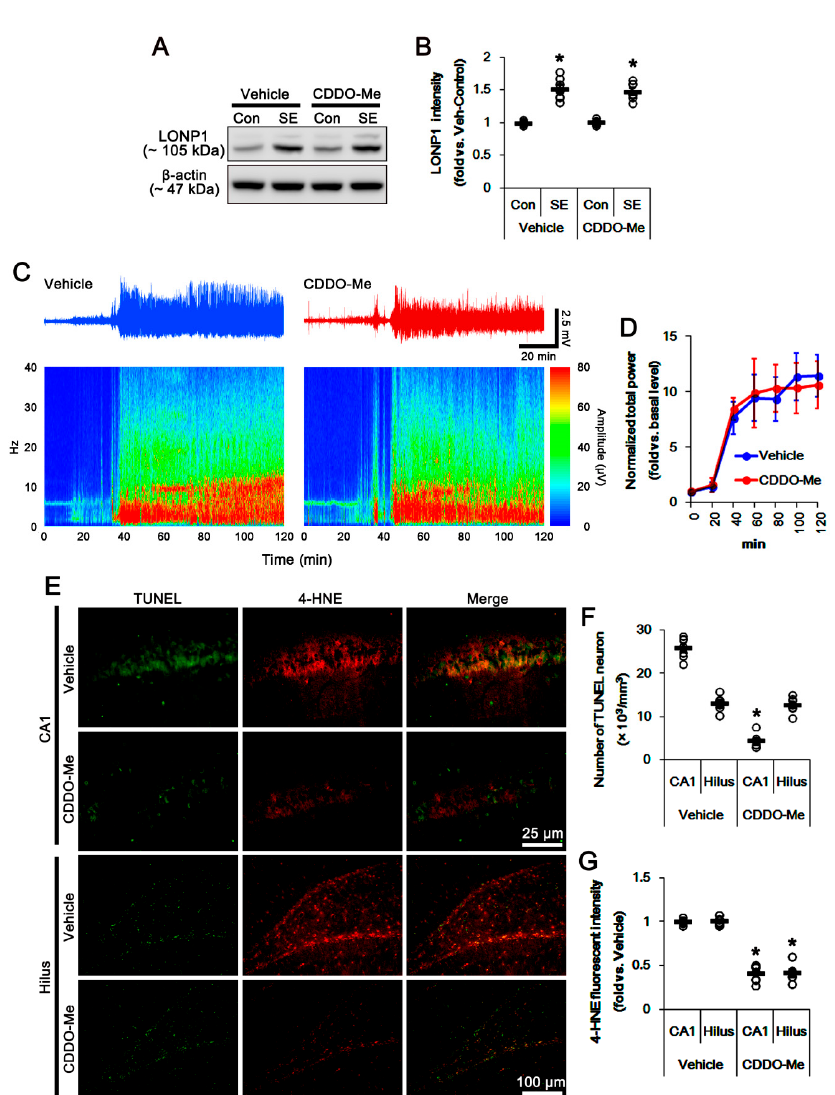
Figure 1. E ff ects of 2-Cyano-3,12-dioxo-oleana-1,9(11)-dien-28-oic acid methyl ester (CDDO-Me) on Lon protease-1 (LONP1) expression, seizure activity and neuronal damage in response to pilocarpine. ( A – B ) E ff ect of CDDO-Me on LONP1 expression in response to pilocarpine. Pilocarpine-induced status epilepticus (SE) increases LONP1 expression, which is not a ff ected by CDDO-Me. ( A ) Representative western blots of LONP1 expression. ( B ) Quantification of LONP1 expression based on western blot data. Open circles indicate each individual value. Horizontal bars indicate mean value (mean ± S.E.M.; * p < 0.05 vs. control animals, respectively; n = 7). ( C – D ) E ff ect of CDDO-Me on seizure activity in response to pilocarpine. CDDO-Me does not influence seizure activity induced by pilocarpine. ( C ) Representative electroencephalogram (EEG) traces and frequency-power spectral temporal maps in response to pilocarpine. ( D ) Quantification of total EEG power (seizure intensity) in response to pilocarpine. Open circles indicate each individual value. Horizontal bars indicate mean value (mean ± S.E.M.; n = 7, respectively). ( E – G ) E ff ects of CDDO-Me on neuronal death and 4-hydroxy-2-nonenal (4-HNE) signals following SE. CDDO-Me mitigates CA1 neuronal damage, but not hilus interneurons, although it reduces 4-HNE signals in both neurons. ( E ) Representative photos of double immunofluorescent staining for terminal deoxynucleotidyl transferase dUTP nick end labeling (TUNEL) and 4-HNE. ( F ) Quantifications of the number of TUNEL positive neurons and ( G ) and the fluorescent intensity of 4-HNE in response to pilocarpine. Open circles indicate each individual value. Horizontal bars indicate mean value (mean ± S.E.M.; * p < 0.05 vs. vehicle; n = 7,